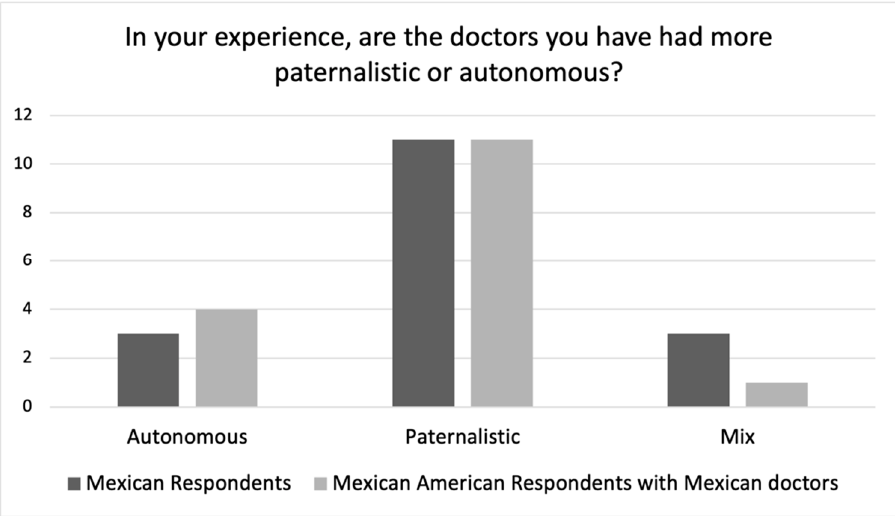
Figure 4. Mexican American vs. Mexican Respondent Experiences.